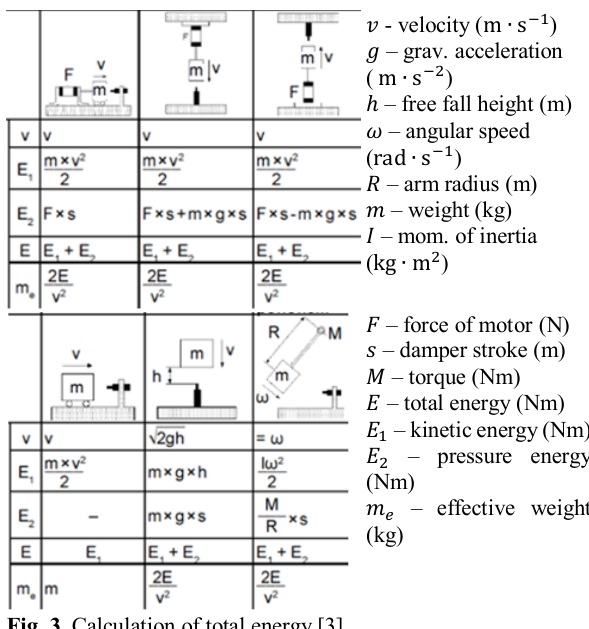
Fig. 2. Damping of semi-rotary motor [2]